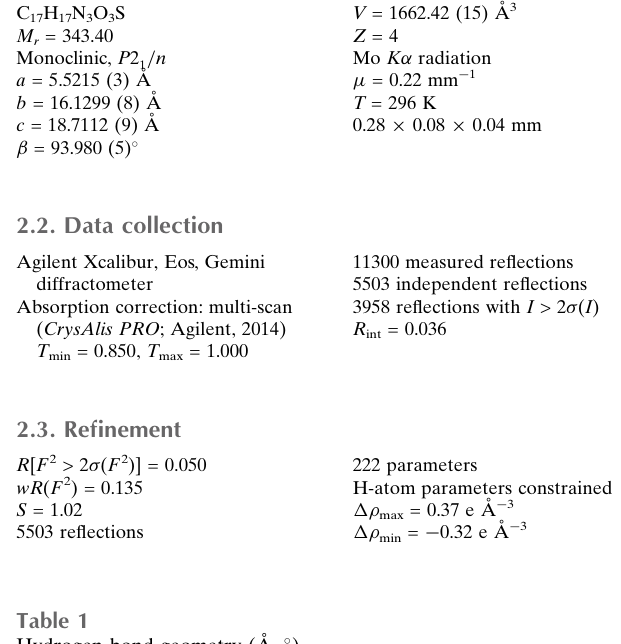
Hydrogen-bond geometry (A˚ , (cid:2) ). Cg 4 is the centroid of the C9–C14